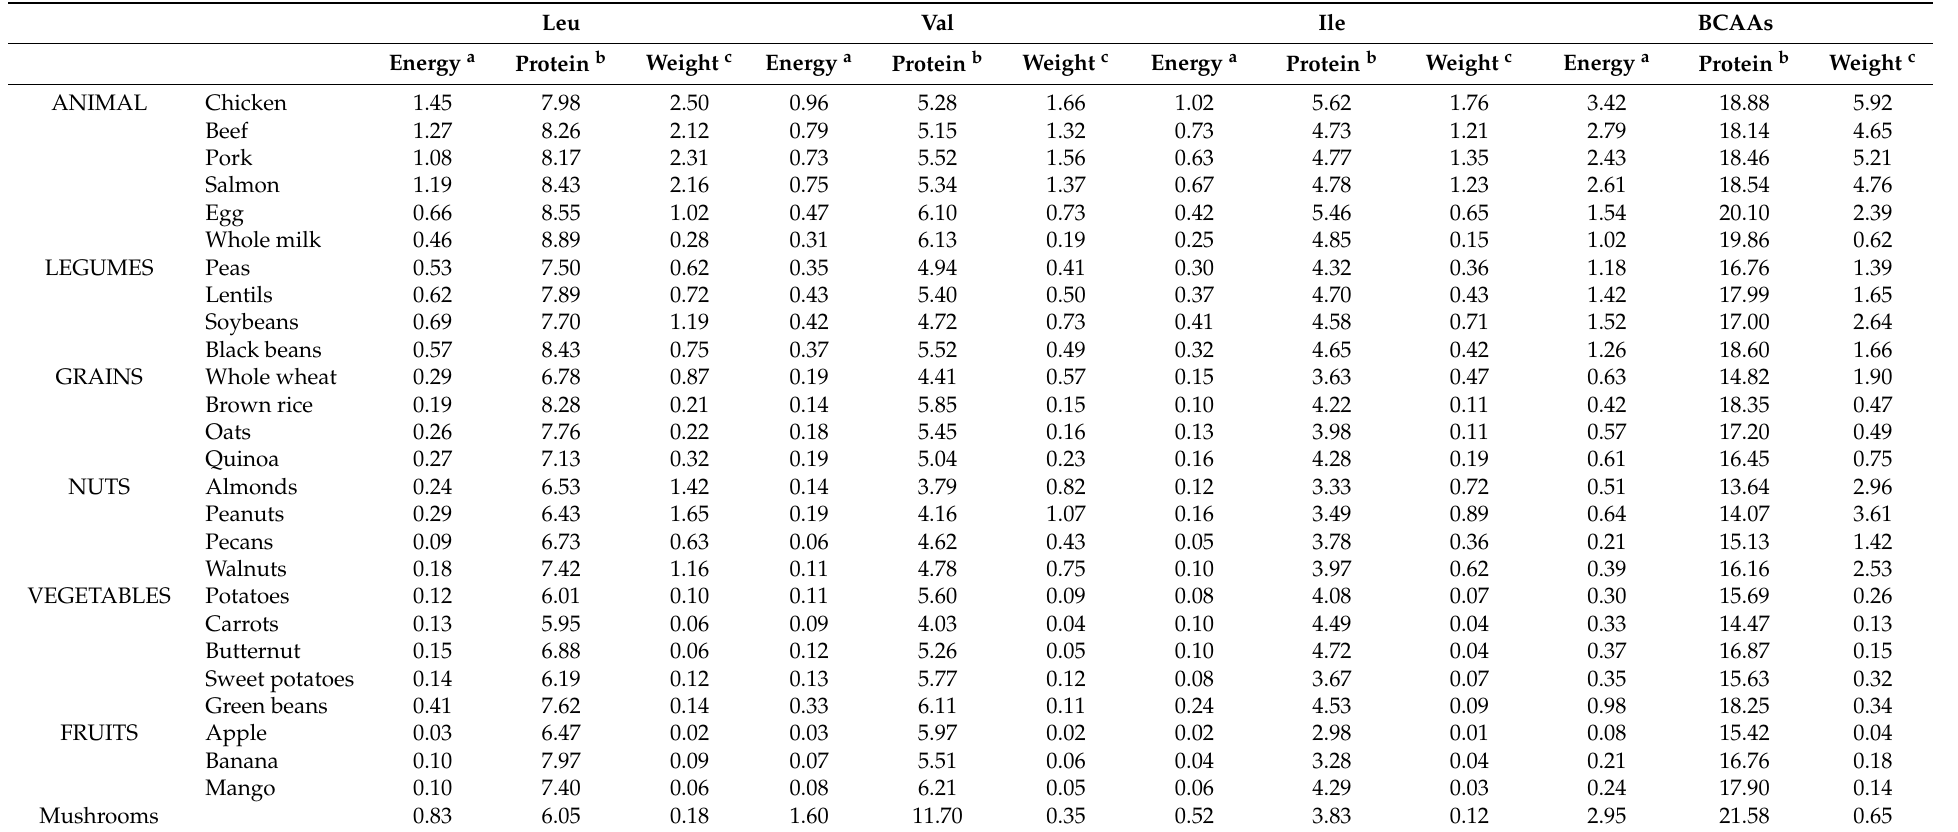
Table 1. BCAA content of different